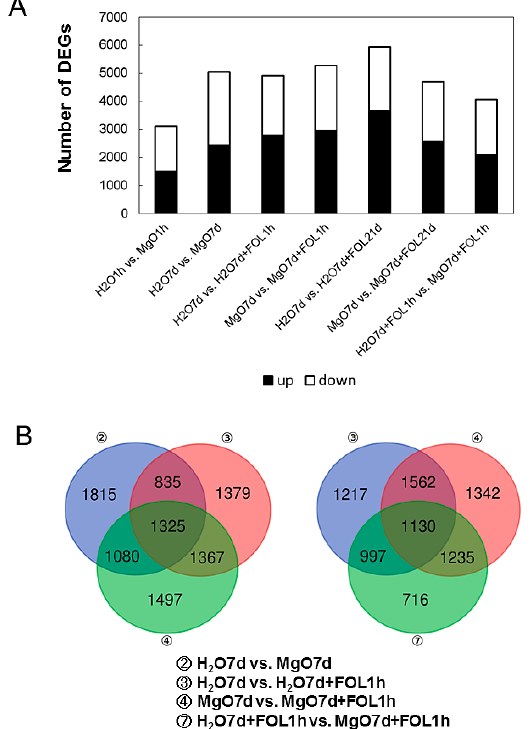
Figure 2. Number of DEGs in seven comparative groups. ( A ) Number of upregulated and downregulated genes. ( B ) Venn diagrams showing the number of DEGs in different three sample comparisons.